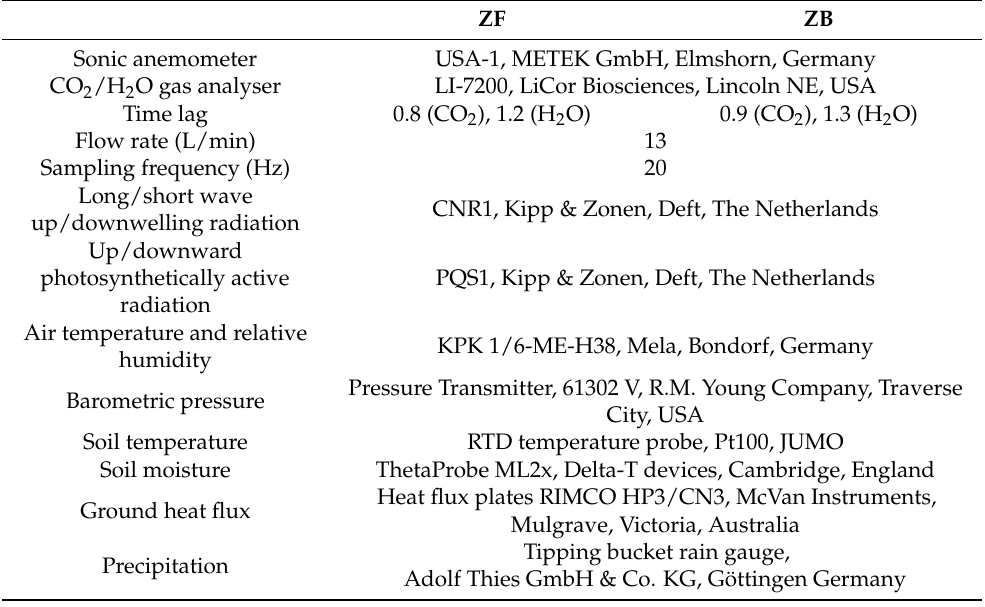
Table 2. Instrument setup and sensor types of the flux towers at the Zotino